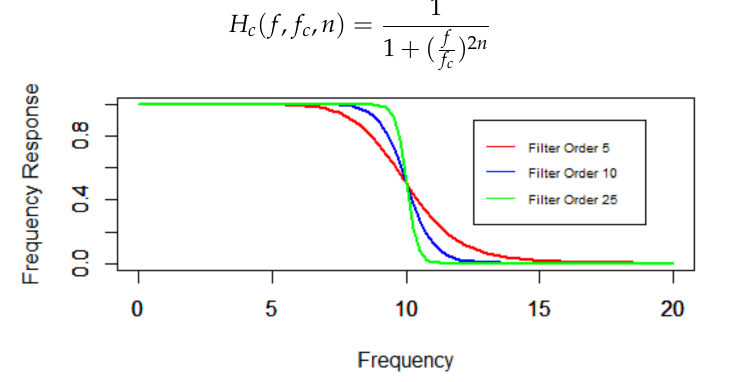
Figure 3. Examples Butterworth Frequency Responses, critical frequency =